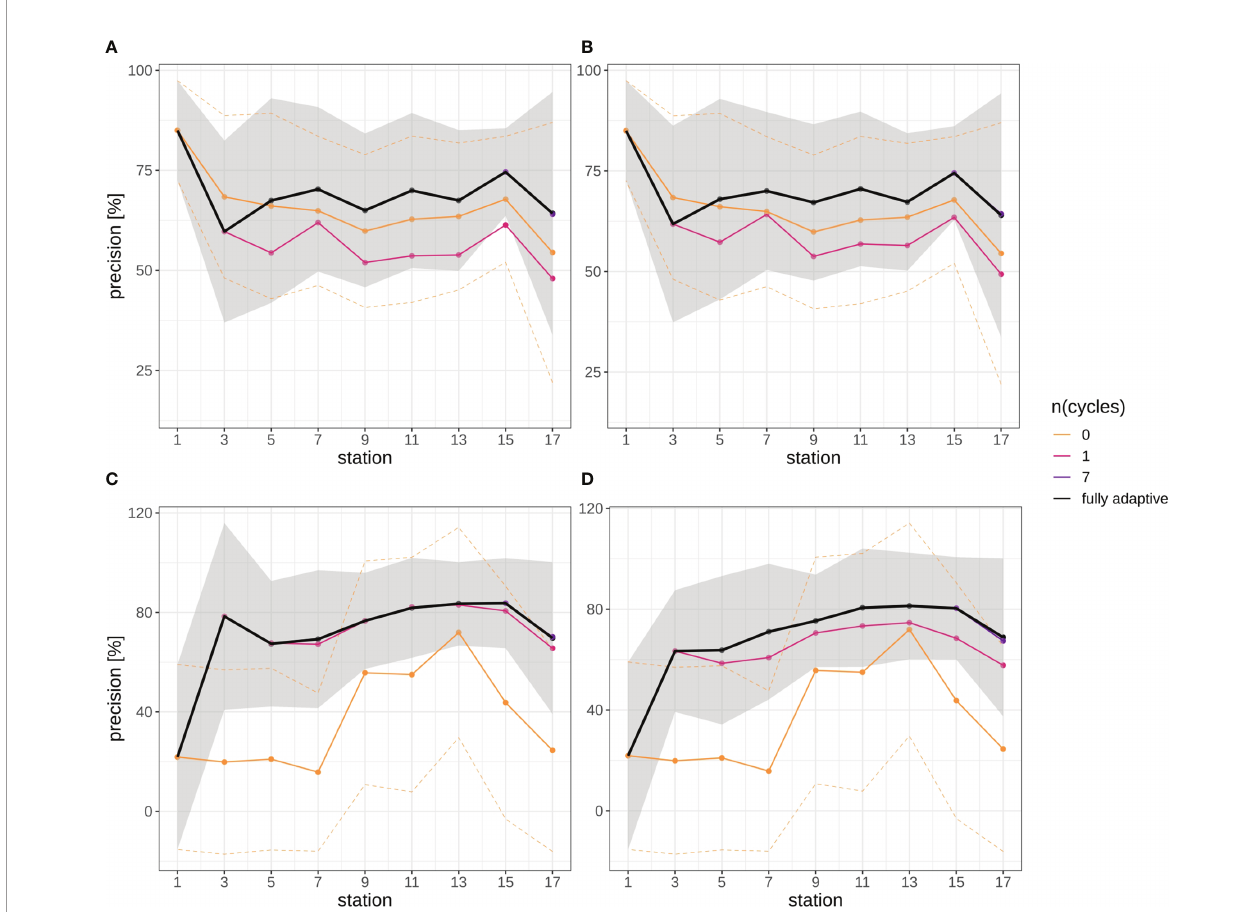
FIGURE 7 | Precision trajectories for different modes of adaptation using the DOC. Solid black line represents weighted mean of the fully-adaptive implementation, grey area denotes the corresponding weighted standard deviation. Colored solid and dashed lines represent weighted mean and weighted standard deviation of less-adaptive implementations (denoted by the number of adaptation cycles). (A) : September survey, fi rst replicate, (B) September survey, second replicate; (C) : December survey, fi rst replicate, (D) : December survey, second replicate. Replicates differ in the random selection of images for training-set updates and random parameter initializations of models before training (see Case Studies – North Sea Surveys ). Trajectories for all nine adaptation modes are shown in Figure SI XI/3